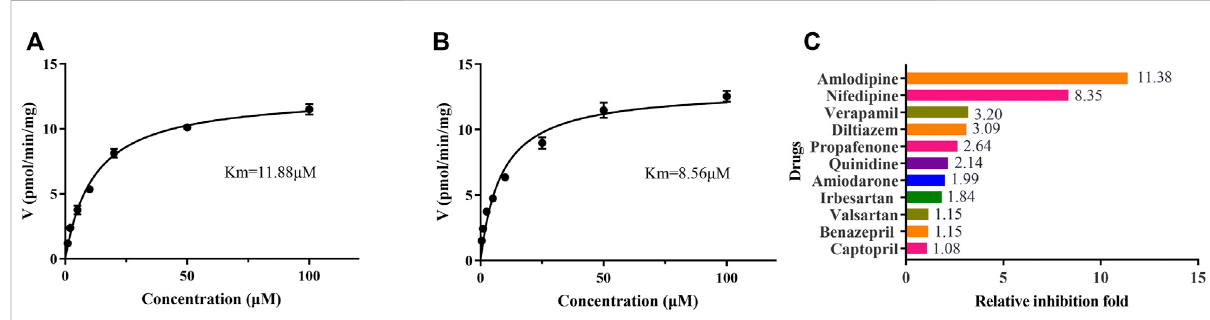
FIGURE 3 The Michaelis – Menten kinetics of vonoprazan in RLMs (A) and HLMs (B) , and the relative inhibition effects of eleven cardiovascular drugs exerted on vonoprazan (C)